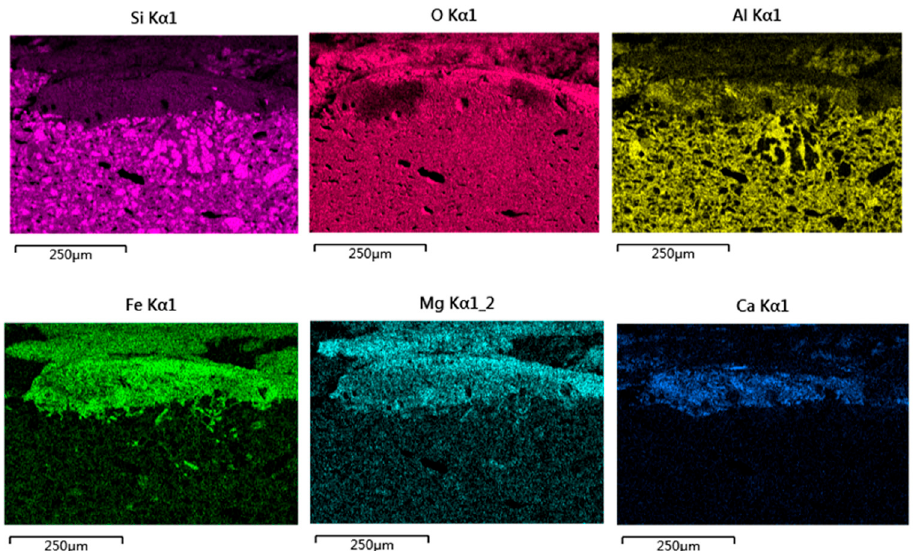
Figure 15. Single-element mapping images of the cross-section at the position of the residual glaze of sample DL-1. Table 4. EDS analysis results of the alteration products and deposits (wt%). Figure Position Mg Al Si Fe Figure 14 Alteration products in the interlayer (P22)